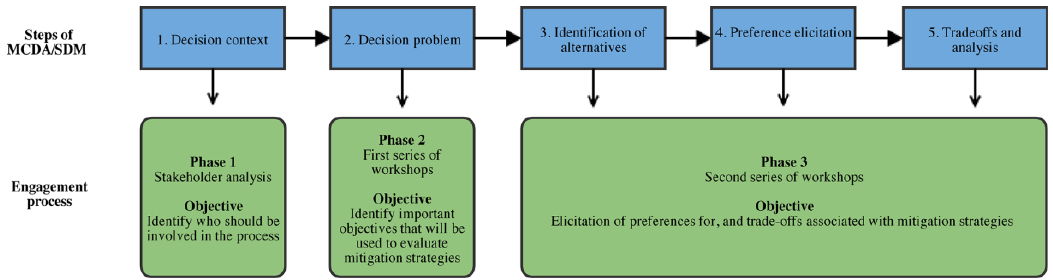
Figure 1. Overview of three phases of engagement process and how they integrate the five steps of multi-criteria decision analysis/Structured Decision Making.